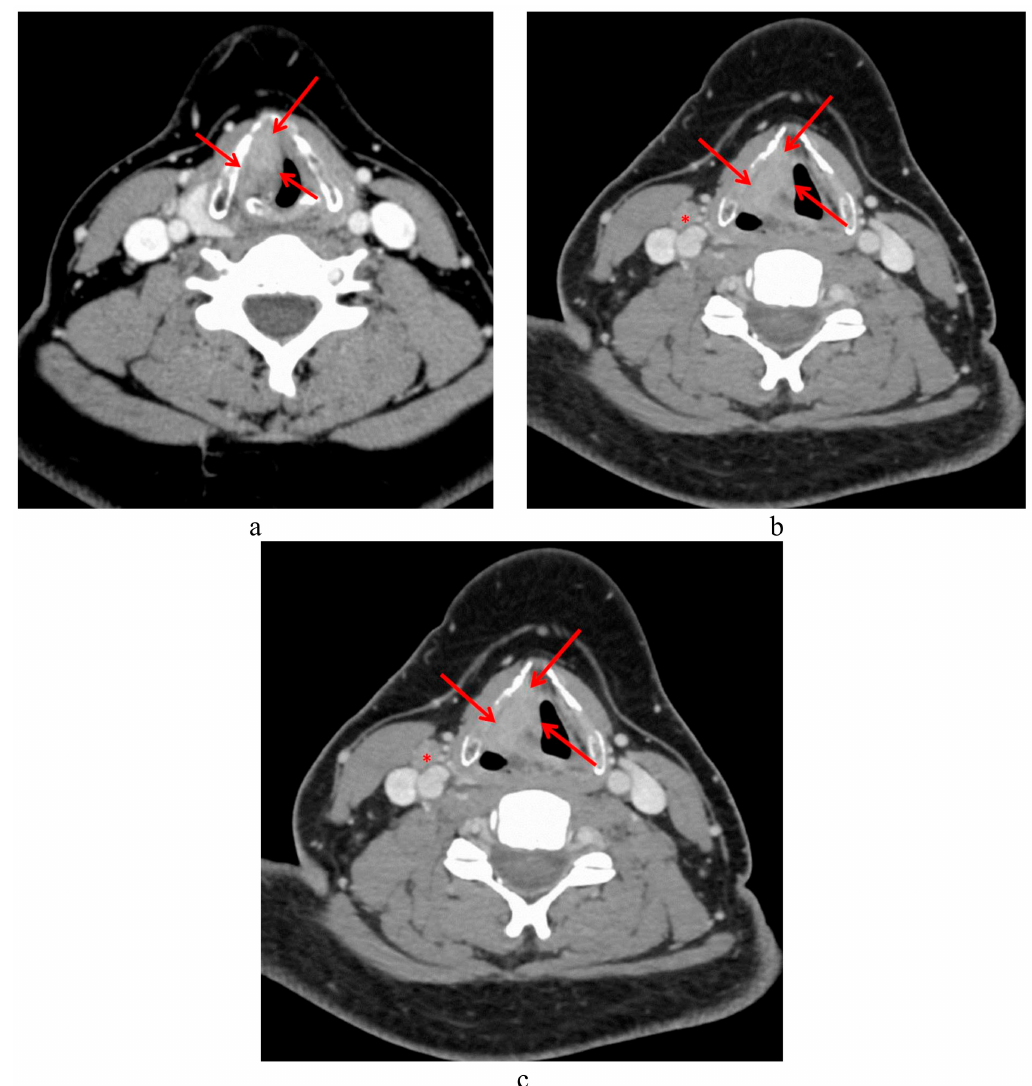
Figure 2. CT scan of a 36-year-old patient with T3 laryngeal cancer (red arrows) involving the right glottic and supraglottic levels with laryngeal immobility, and a left metastatic lymph node in level III (red asterix). Indication of inclusion in a larynx preservation program. Pretreatment CT scan ( a , b ) and CT-scan after three cycles of induction chemotherapy showing a poor response to therapy ( c